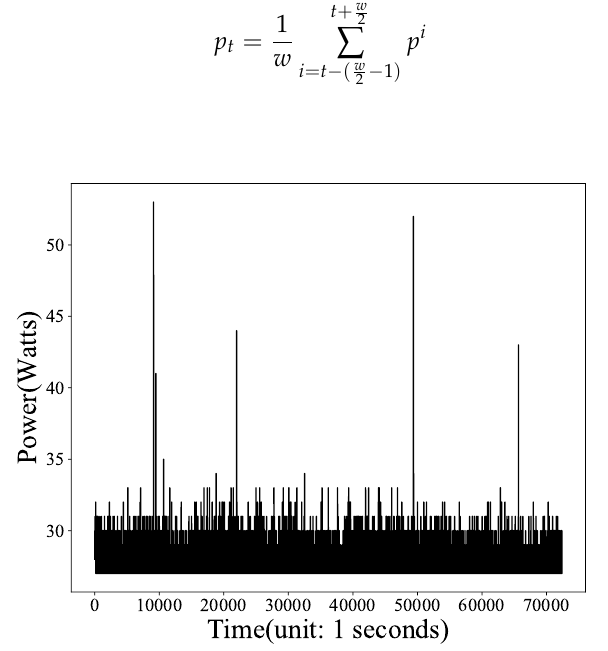
Figure 7. The power consumption when workload is